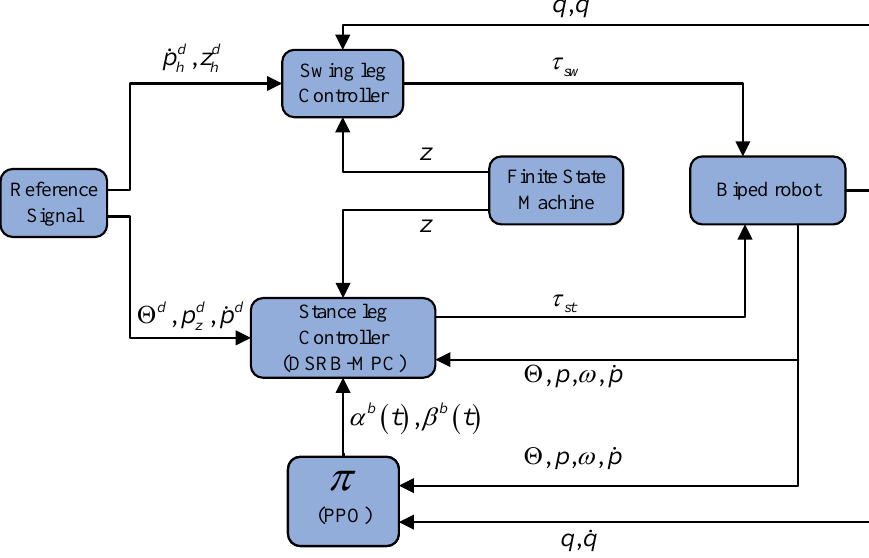
Figure 1. The block diagram of the control architecture. The stance leg controller and the policy run at 80 Hz, and the swing leg controller runs at 230 Hz. Reference signal includes desired torso